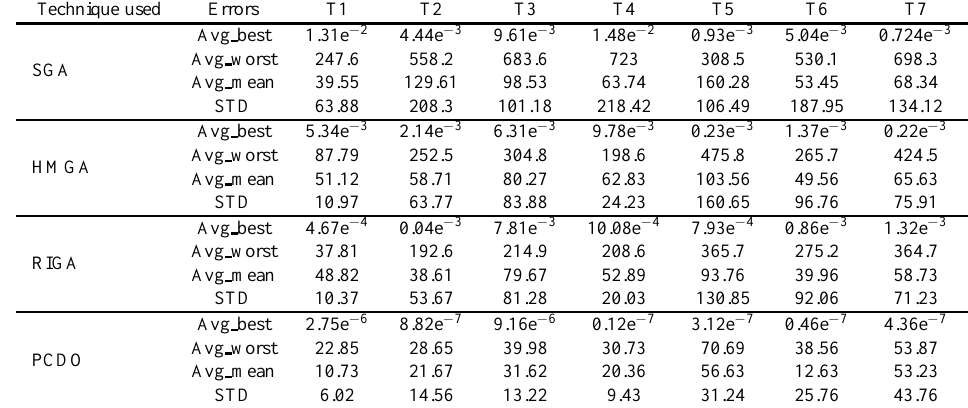
Table 6. Error Values Achieved for Problems F 6 .